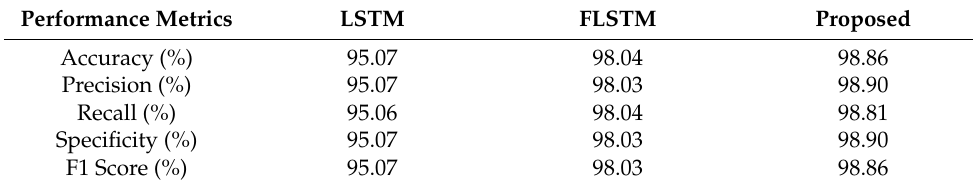
Table 6. Comparing performance measures of the proposed system.